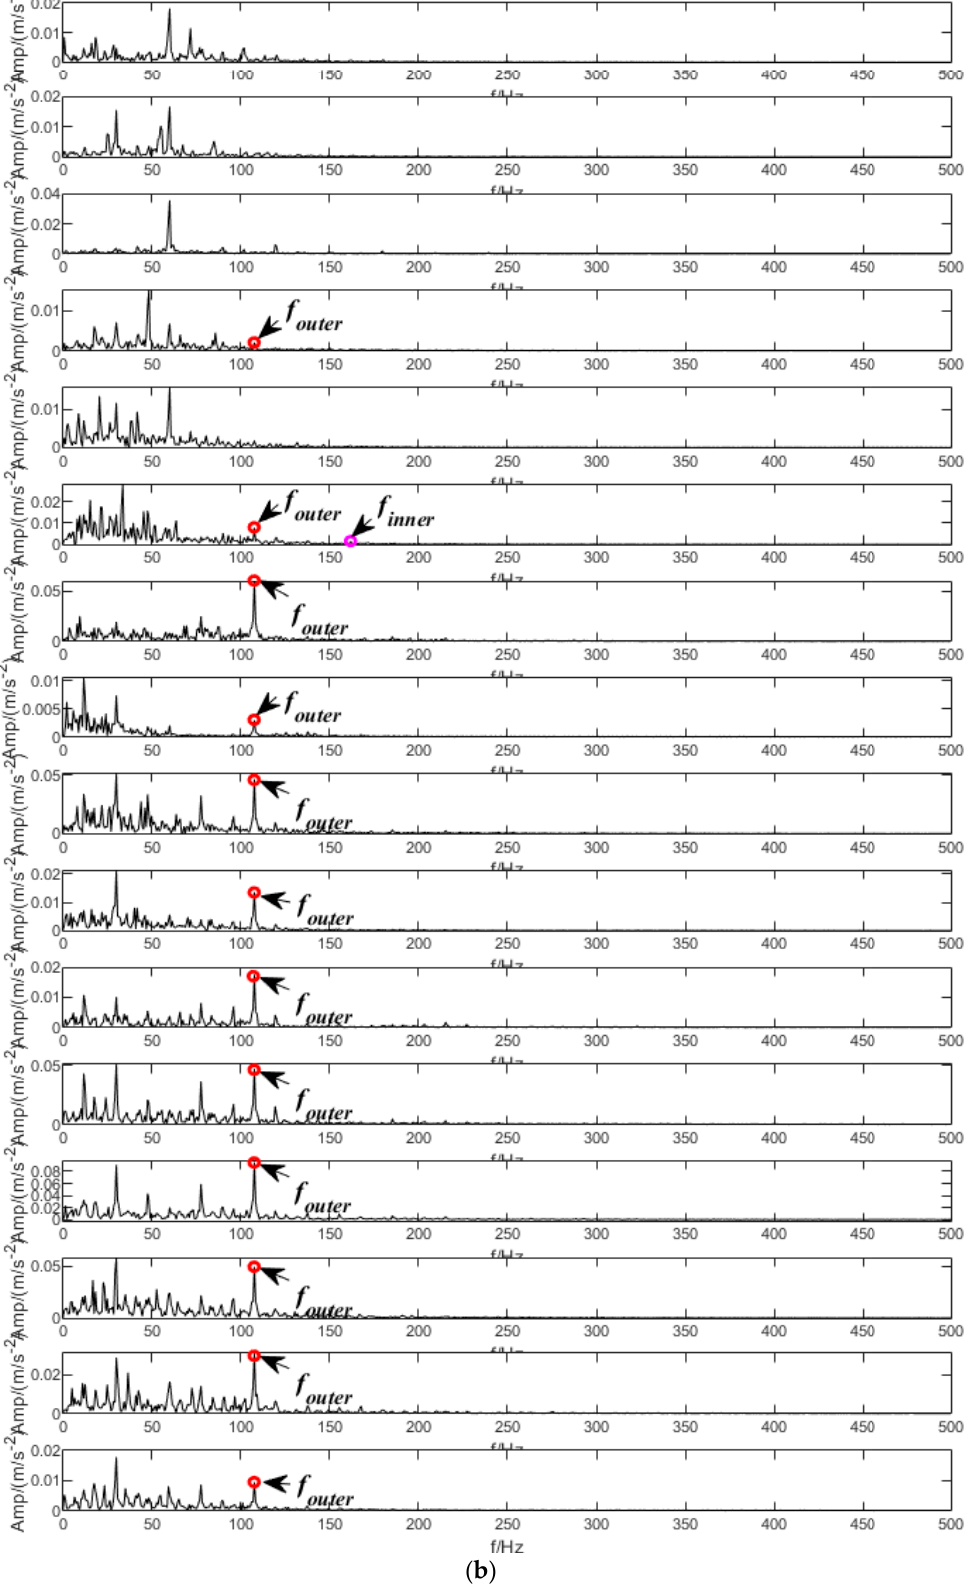
Figure 17. The IMF components and envelope spectrums using SVMD. ( a ) Decomposed modes. ( b ) Envelope spectrums.